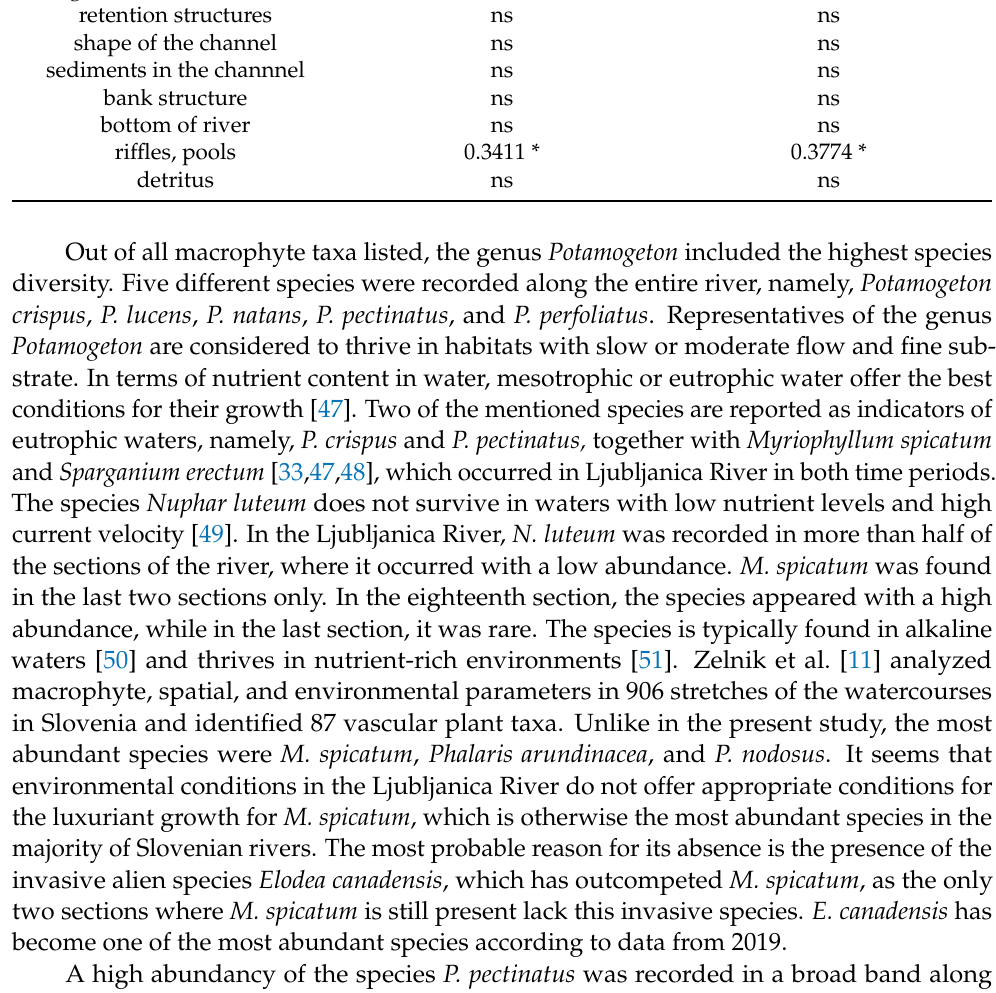
[O2] ns water temperature ns ns saturation (O2) ns ns distance from the source − 0.3306 * ns land use 0.3940 * width of RZ vegetation structure of RZ ns ns retention structures shape of the channel ns sediments in the channnel ns ns bank structure ns ns bottom of river ns ns riffles, pools 0.3411 * 0.3774 * detritus ns